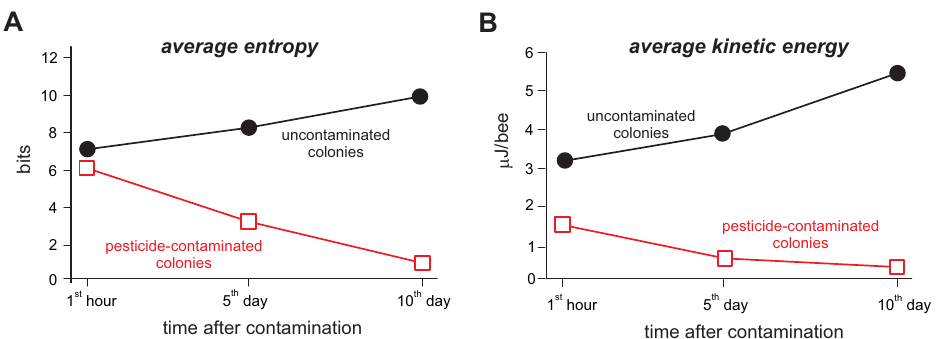
Figure 3. Dynamic quantification of swarm entropy ( A ) and kinetic energy ( B ) within a hive of Apis mellifera bees. The measurements were based on the trajectories traveled by labeled bees (i.e., either pesticide-unexposed individuals or individuals that were sublethally exposed to a commercial formulation containing the synthetic fungicides chlorothalonil and thiophanate-methyl). Each symbol represents the average value of four colonies. The measurements were conducted at the 1st hour, 5th and 10th day after the introduction of labeled bees within the colony.